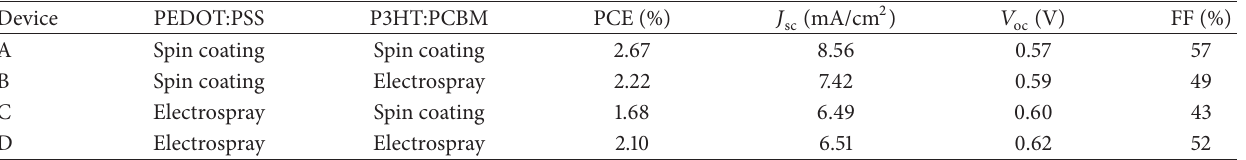
Table 1: Summary of device performance for the OPVs discussed in the work.